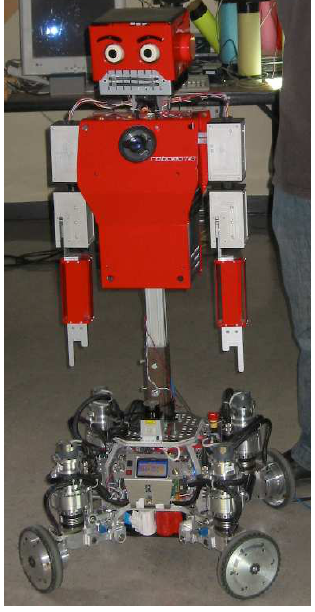
and joint torque actuators [27], while the MEKA torso uses SEAs [3, 4]. Care-O-Bot has force/torque control manipulators [5]. None are capa-